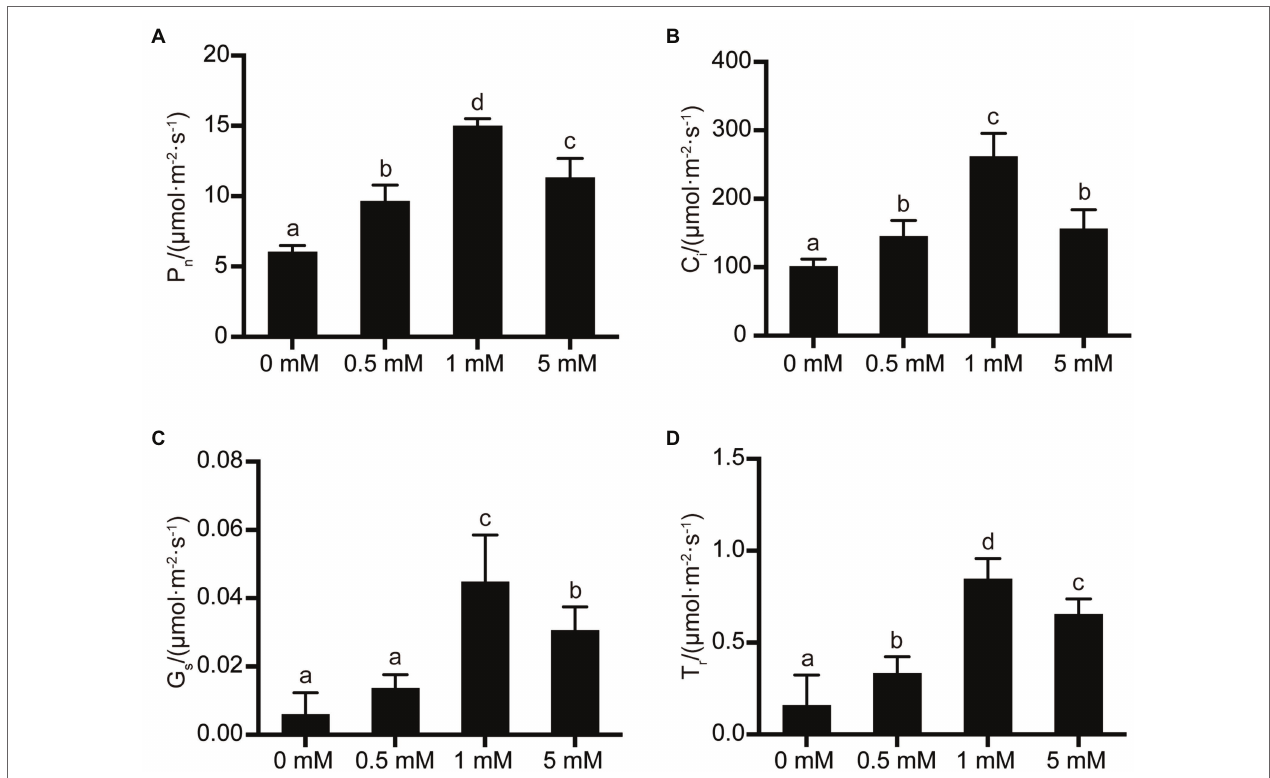
FIGURE 4 | The effects of P treatments on photosynthetic parameters in pear seedling leaves. (A) The net photosynthetic rate of pear seedlings under different P levels; (B) The intercellular CO 2 concentration of pear seedlings under different P levels; (C) The stomatal conductance of pear seedlings under different P levels; and (D) The transpiration rate of pear seedlings under different P levels. Data are presented as mean ± standard deviation of three replicates, and each replicate is based on measurements made from three plants. Samples in a bar chart with a common superscript letter are not significantly different ( p > 0.05), according to the Duncan’s multiple range